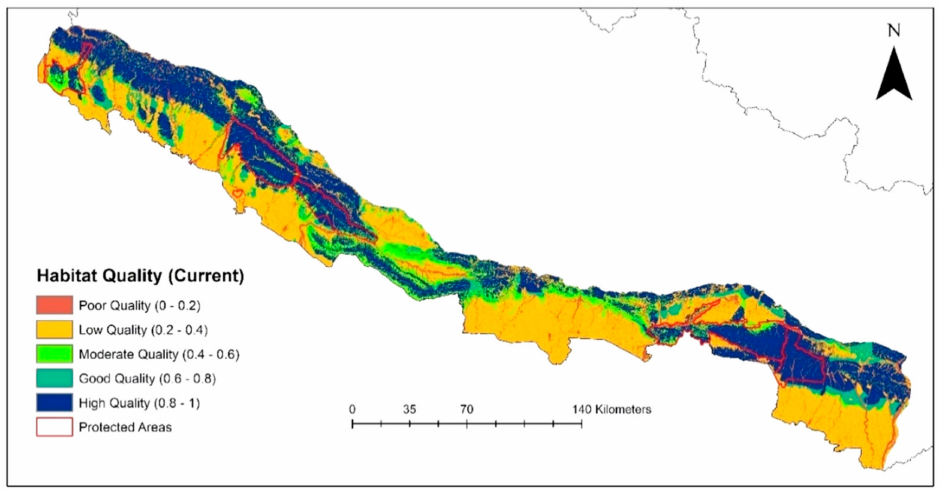
Figure 3. Land use and land cover (LULC) of the Terai Arc Landscape.